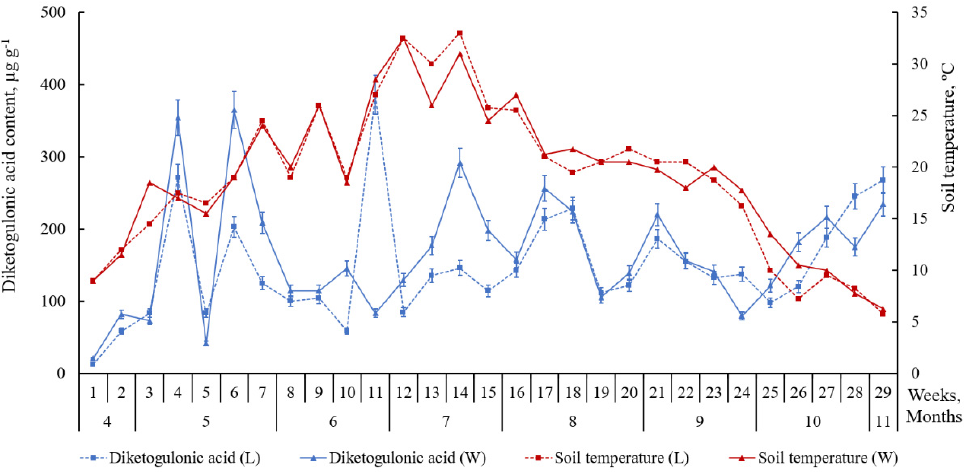
Figure 6. Content of diketogulonic acid (DKGA) in the leaves of Lathyrus maritimus ( µ g g − 1 DW) and the temperature conditions of the leeward (L) and windward (W) sides of the foredune (April–November 2018). Data expressed as mean values ± standard deviations, (n = 45). Differences considered significant at p ≤ 0.05.